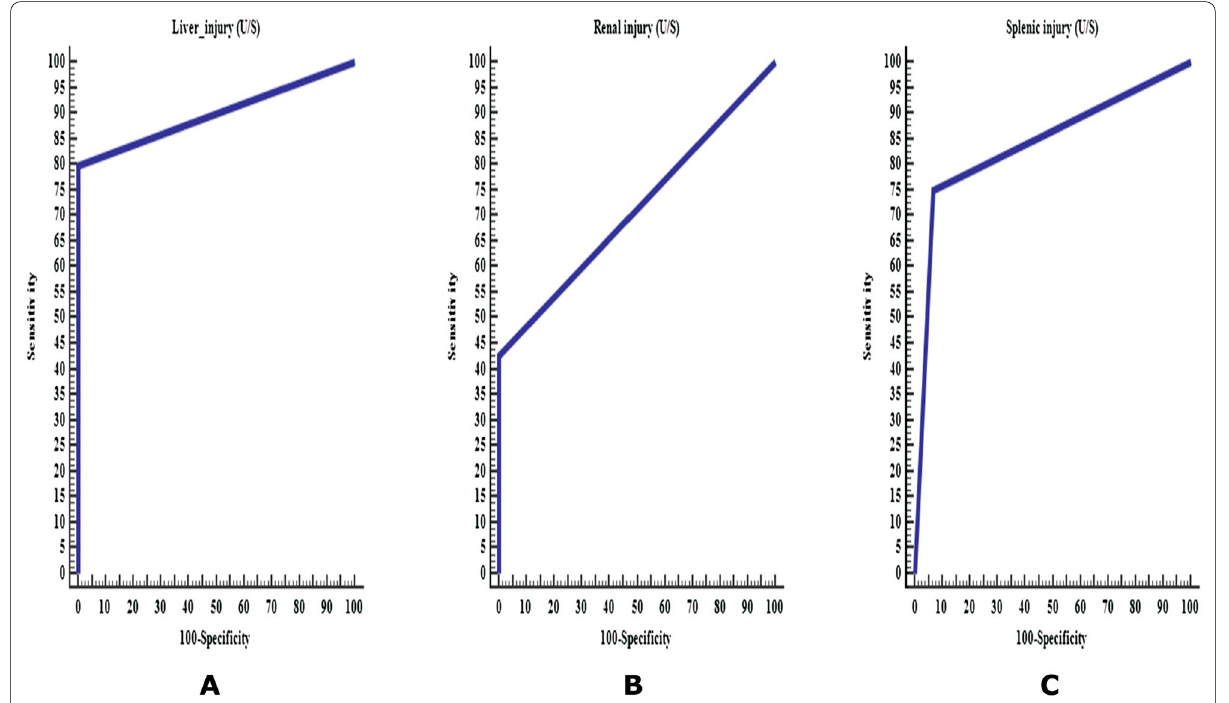
Fig. 1 Diagnostic accuracy of ultrasonography in diagnosing hepatic, splenic and renal